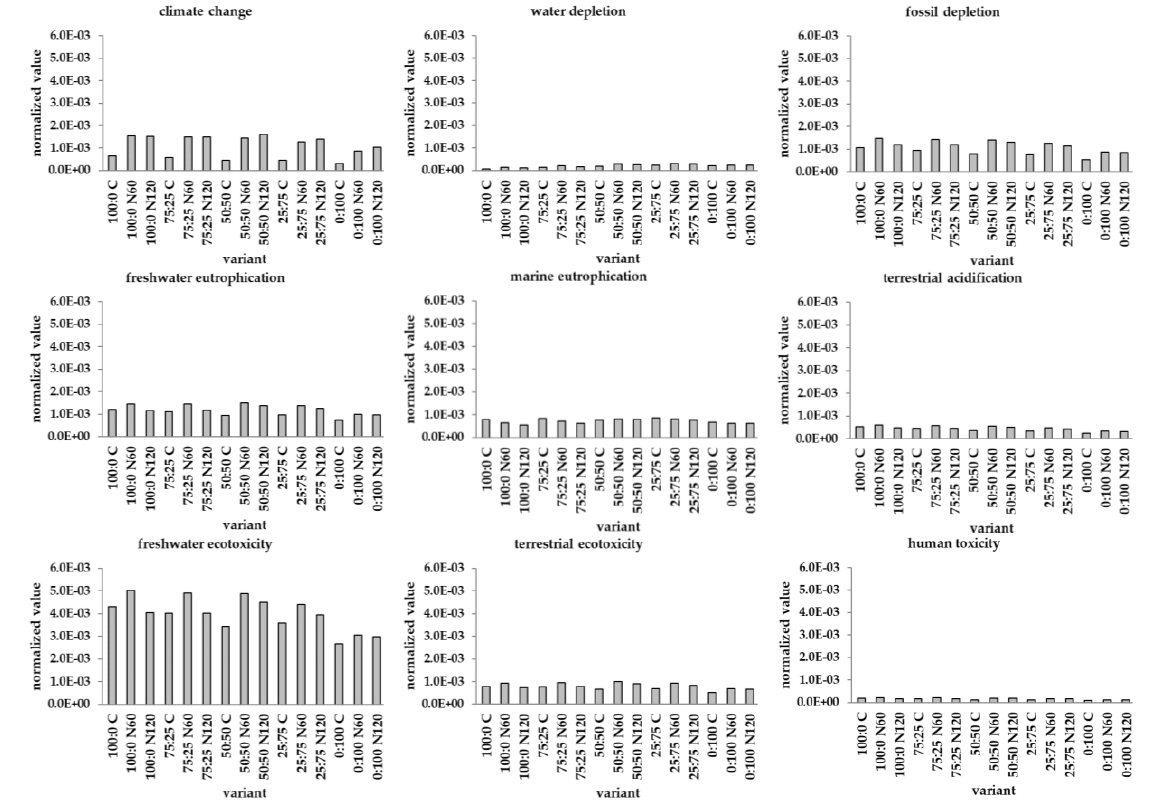
Figure 2. Trends of the environmental impact per 1 kg of grain N yield per ha −1 ; C = Control; N60 = variant with input of